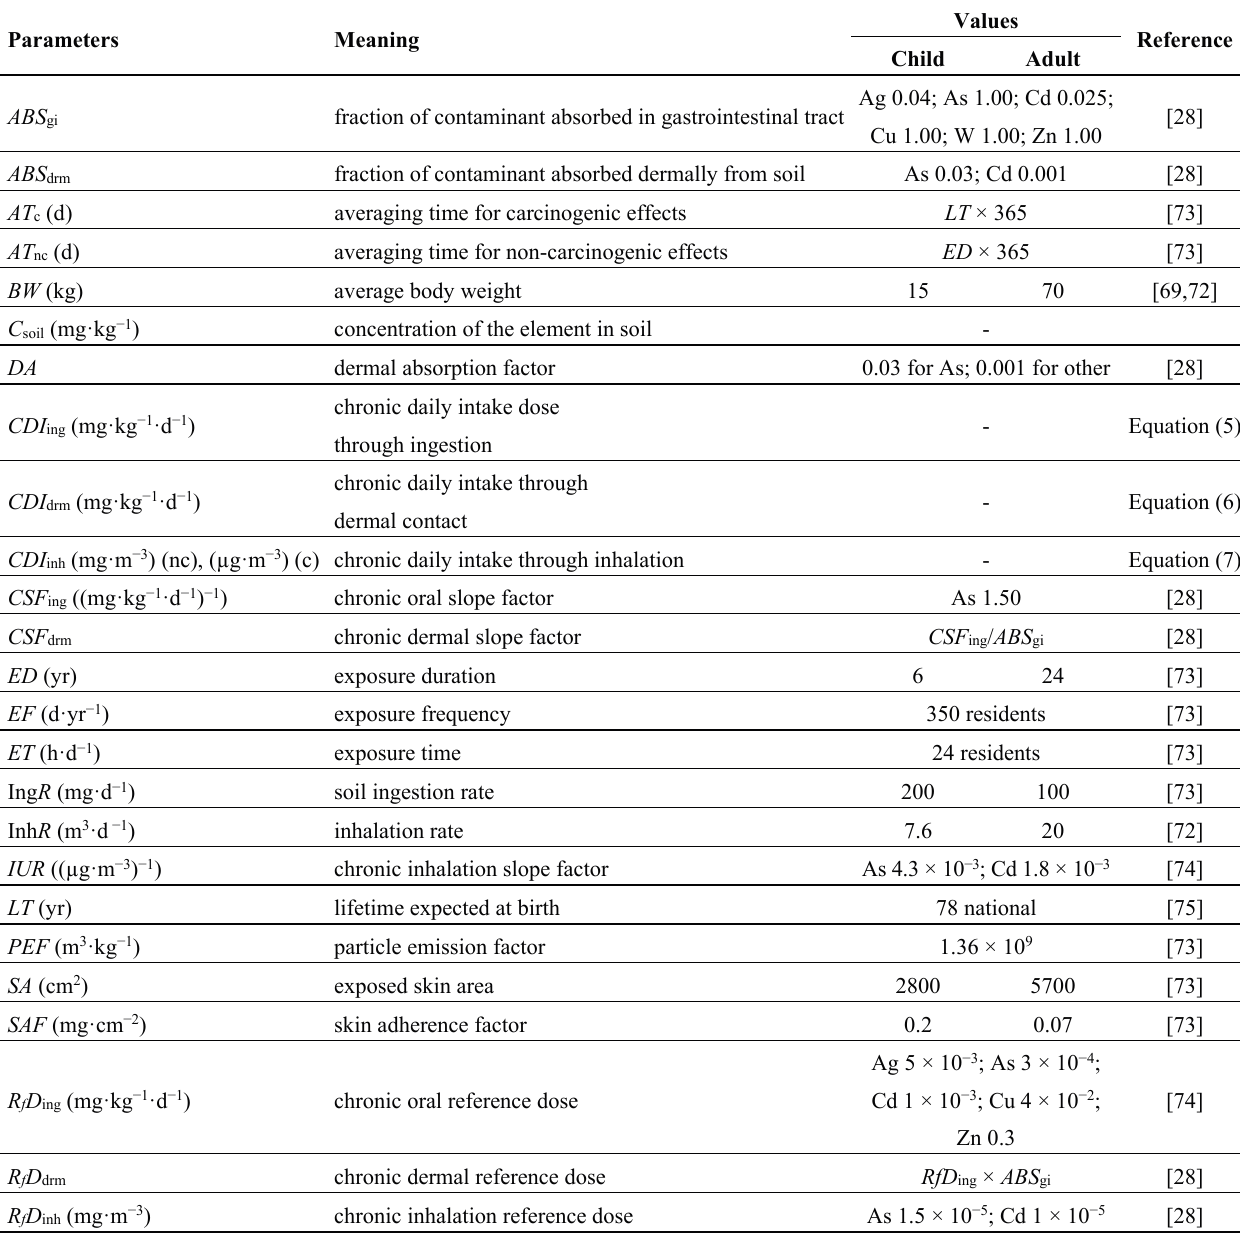
Table 3. Variables for estimation of soil residential risk in the Panasqueira mining